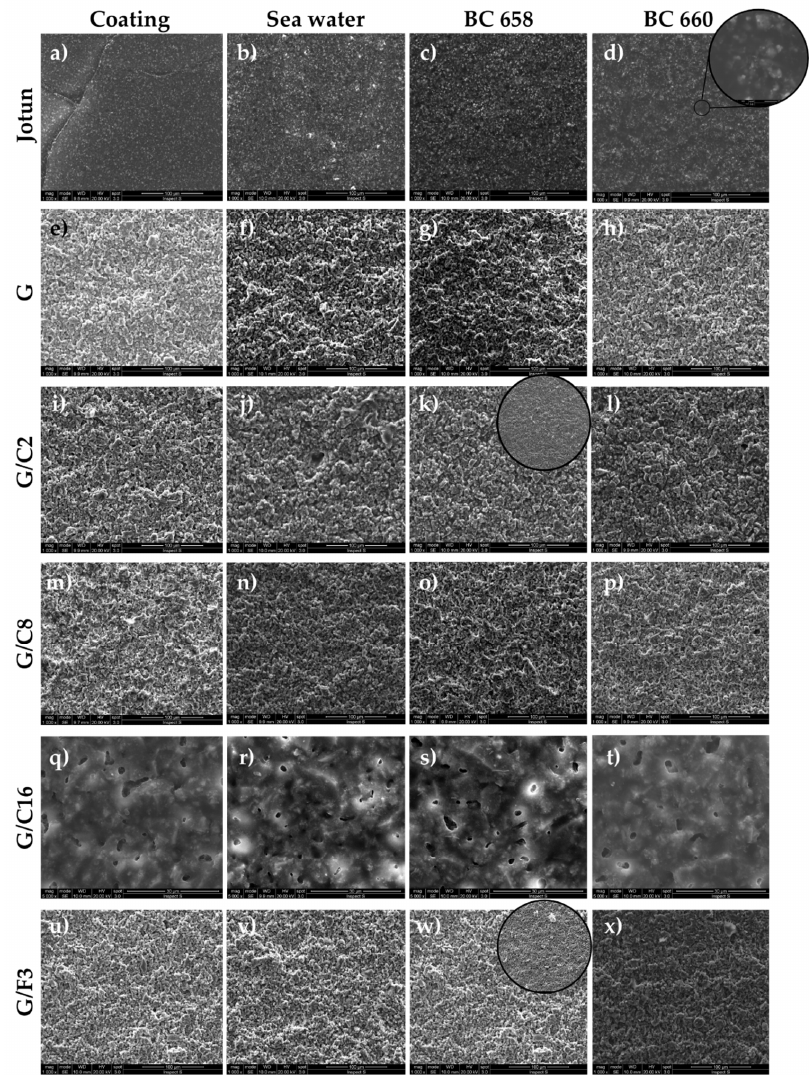
Figure 15. Adhesion of bacteria on treated glasses with coatings (commercial Jotun, ( a – d ); G, ( e – h ); G/C2, ( i – l ); G/C8, ( m – p ); G/C16, ( q – t ); G/F3, ( u – x )). The first column shows the coatings after deposition; the 2nd column shows the coatings after immerging for 24 h in sterile sea water; the 3rd column are the images of the behavior of coating surfaces against the adhesion of strain BC 658 (Gram − ); the 4th column in presence of a suspension of the strain BC 660 (Gram+). The circular images at higher magnification (30 µ m) the bacteria adhering on the